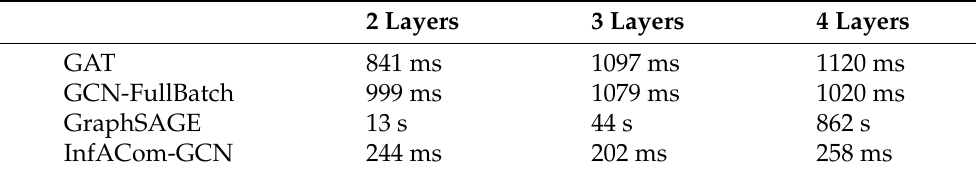
Table 6. Average time of 50 epochs for Citeseer dataset using 2, 3, and 4 layers (the number of hidden units is